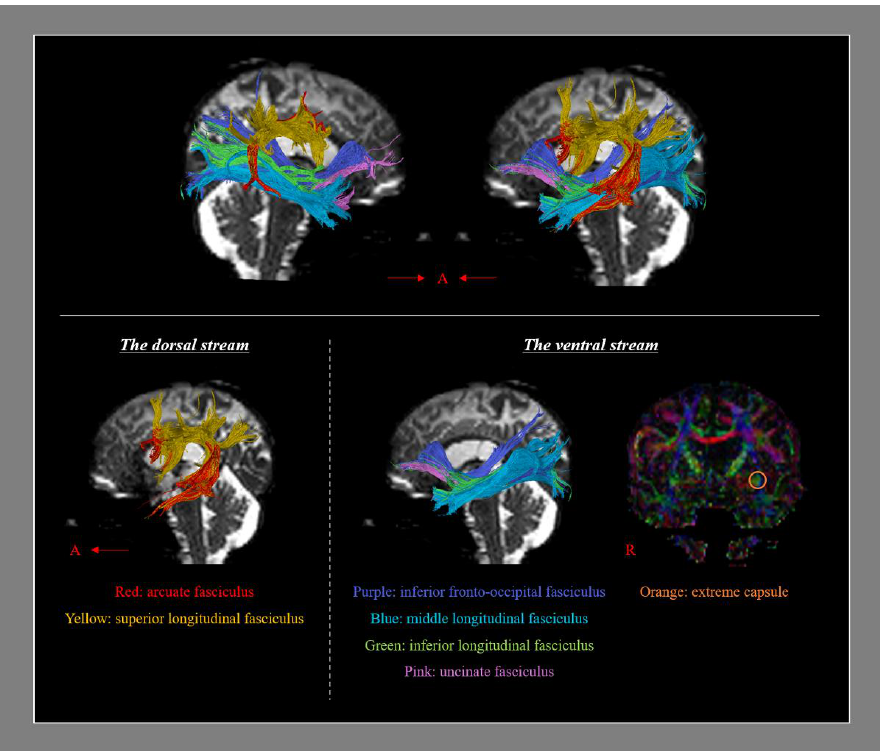
Figure 1. Diffusion tensor tractography for the neural tracts which are involved in language pro- cessing (A: anterior, R: right). The dorsal stream contains the arcuate fasciculus and the superior longitudinal fasciculs, and the ventral stream contains the inferior fronto-occipital fasciculus, the middle longitudinal fasciculus, the inferior longitudinal fasciculus, and the uncinate fasciculus. Table 1. Correlation between the language subdomains and the fractional anisotropy of the lan- guage-related neural tracts reported by Zhang et al. [45].